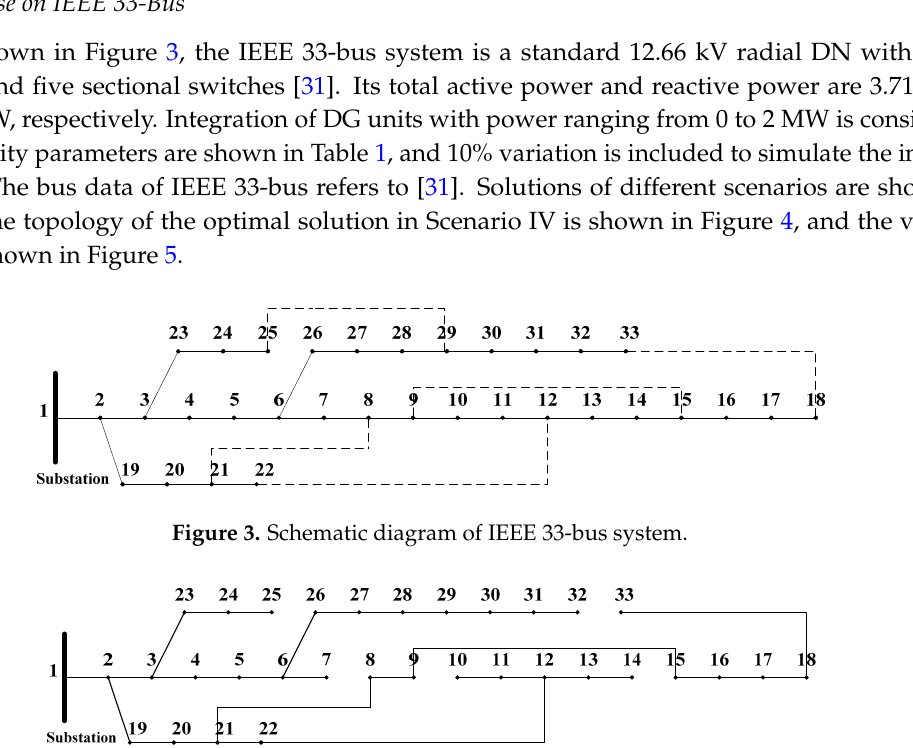
Figure 5. Voltage profiles of IEEE 33-bus system. Table 1. Reliability data of related equipment (with interval data). Items